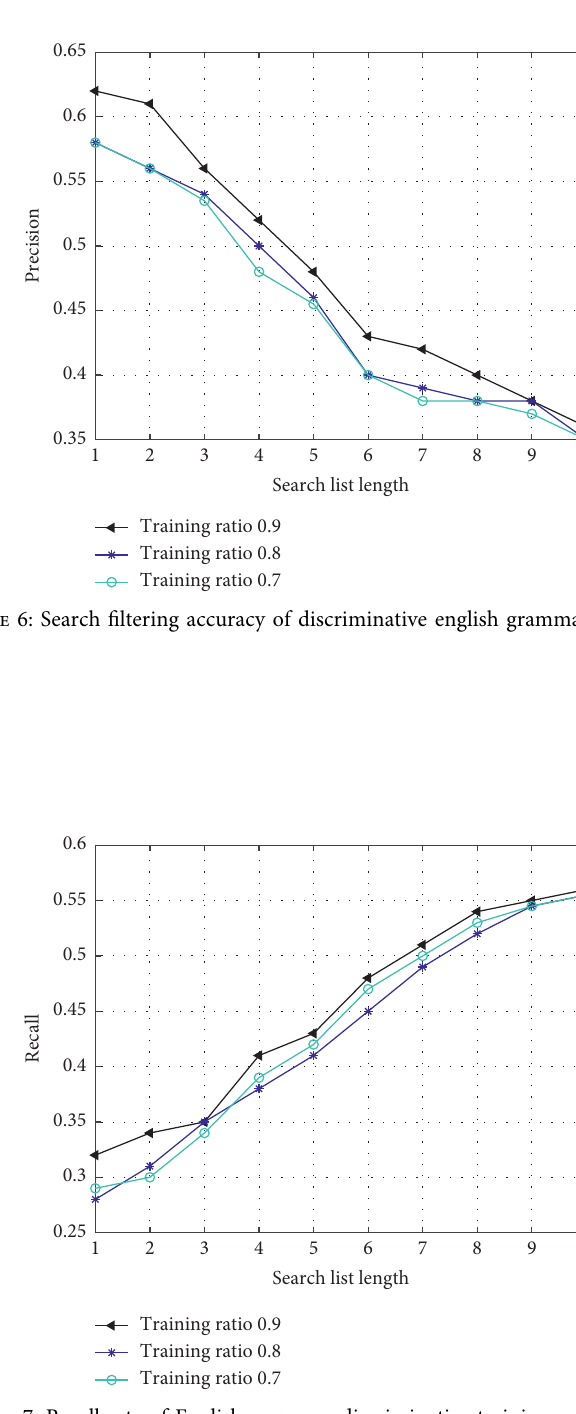
Figure 7: Recall rate of English grammar discriminative training search